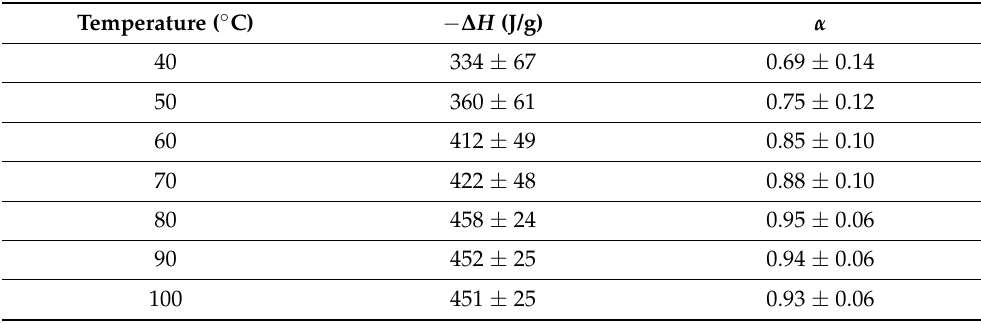
Table 1. Enthalpy of the reaction, ∆ H ( T ), obtained by the isothermal mode and conversion degree, α , at different curing temperatures.